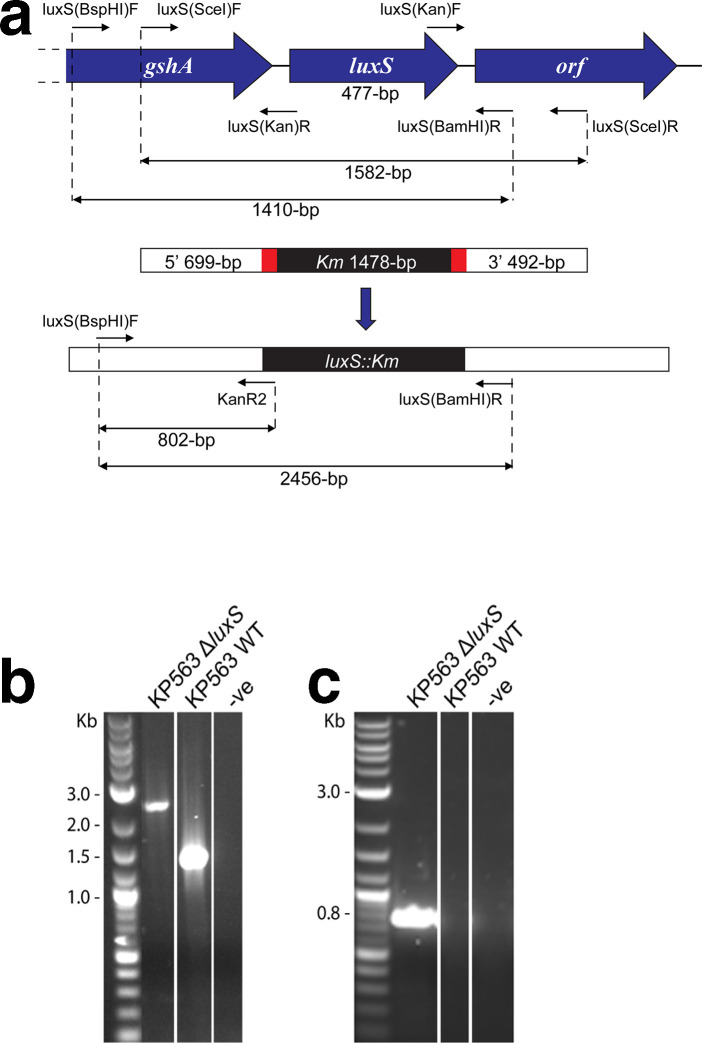
(a) Generation of a
K. pneumoniae
 KP563 ΔluxS mutant. A genetic map is shown of luxS and flanking genes (gshA and an unannotated ORF) in KP563. Short arrows represent approximate locations and directions of primers used. A ΔluxS knockout strain was created via allelic exchange with a DNA fragment containing the kanamycin resistance cassette (Km) flanked by upstream (5′ 699 bp) and downstream (3′ 492 bp) sequences from luxS, as detailed in the Materials and Methods. The regions in red represent 20 bp complementary sequences between the flanking and Km sequences, required for overlapping PCR. Expected amplicon lengths are shown. (b and c) Confirmation of KP563 ΔluxS mutant by PCR. Colony PCR was performed on KP563 wild-type (WT) and ΔluxS mutant using (b) Primer pair 1 luxS(BspHI)F/luxS(BamHI)R, and (c) Primer pair 2 luxS(BspHI)F/KanR2. Primer pair 1 produced an expected ~1 kb product size difference. Primer pair 2 produced an expected ~0.8 kb product for the ΔluxS mutant only. Negative (-ve) is the no-template control.